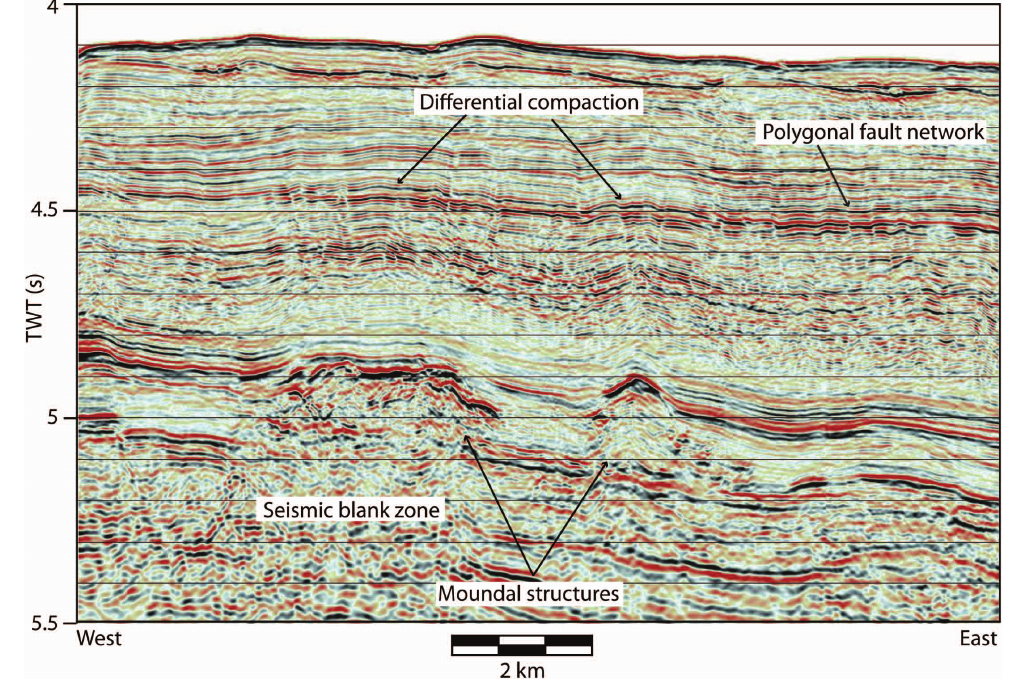
Fig. 13. Seismic line depicting moundal structures lying above the Valanginian-Late Hauterivian breakup unconformity. The extensive differential compaction system that has developed above the moundal structures implies that they are composed of a hard compact